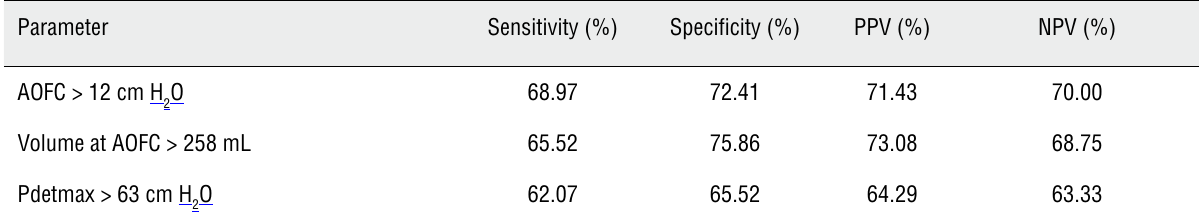
Table 2 - Sensitivity, specificity, positive predictive value and negative predictive value for AOFC, Volume at AOFC and Pdet- max at developed cutoff